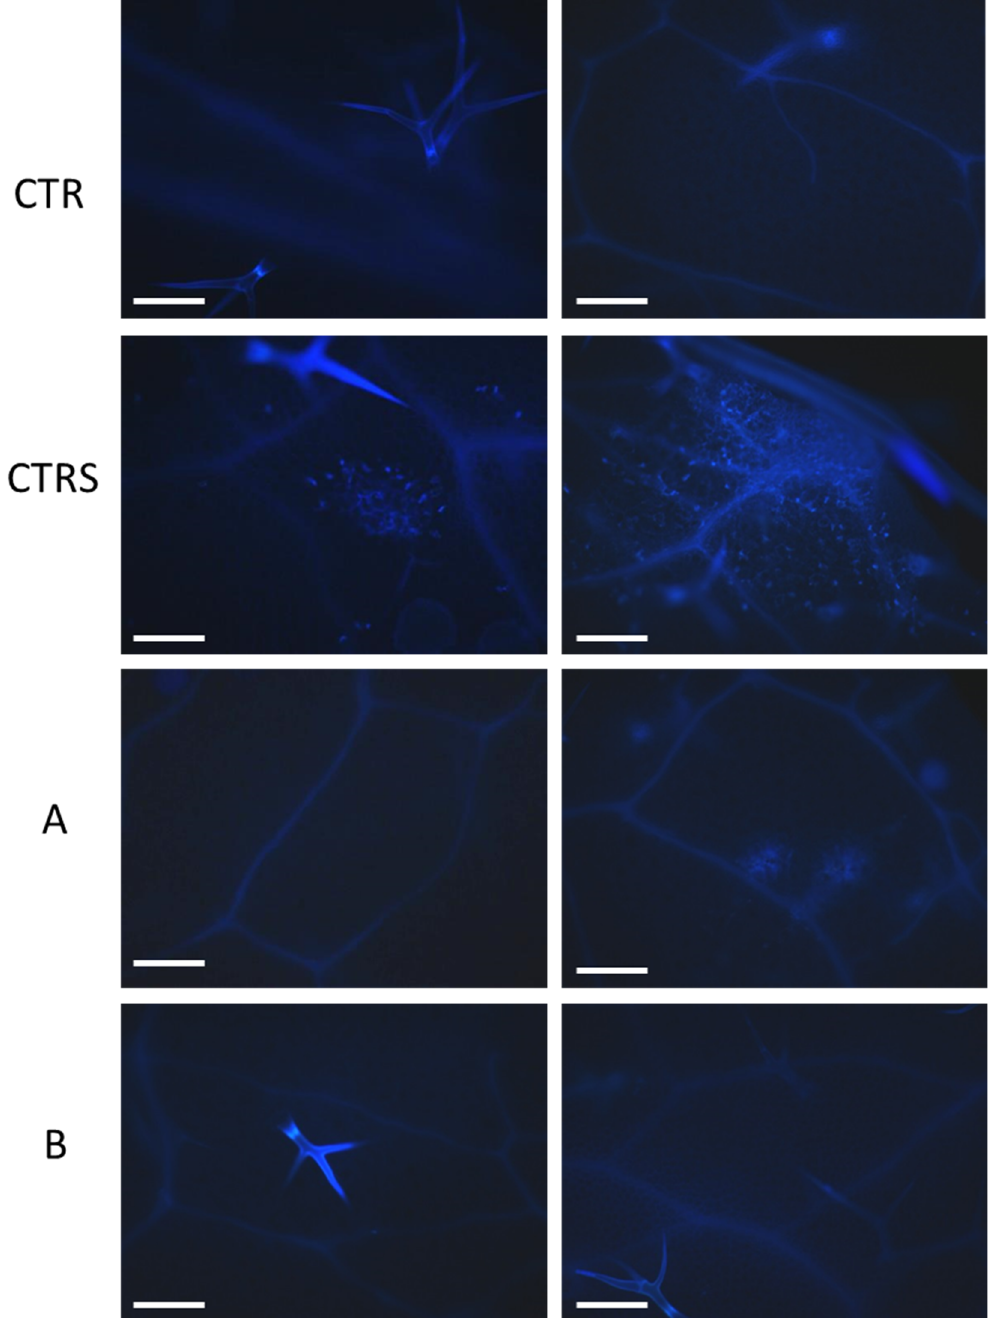
Figure 4. Phenylpropanoid histolocalization by autofluorescence visualization. For each sample one picture was taken from the central area of the leaf blade (left) and one from the leaf border (right). CTR: non-stressed control, CTRS: stressed control, A: Phylgreen, B: Delfan Plus. Bars: 200 µm. The cell membrane breakdown was estimated by measuring the electrolyte